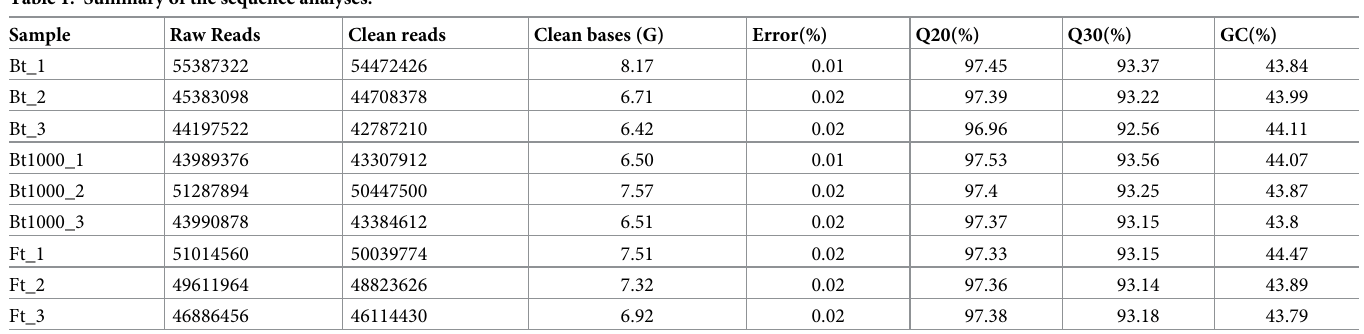
Table 1. Summary of the sequence analyses.